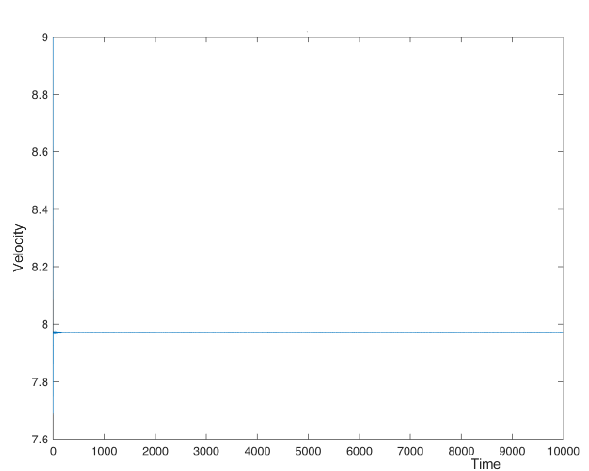
Figure 5. Velocity evolution for a Reynold’s number of 10 4 .